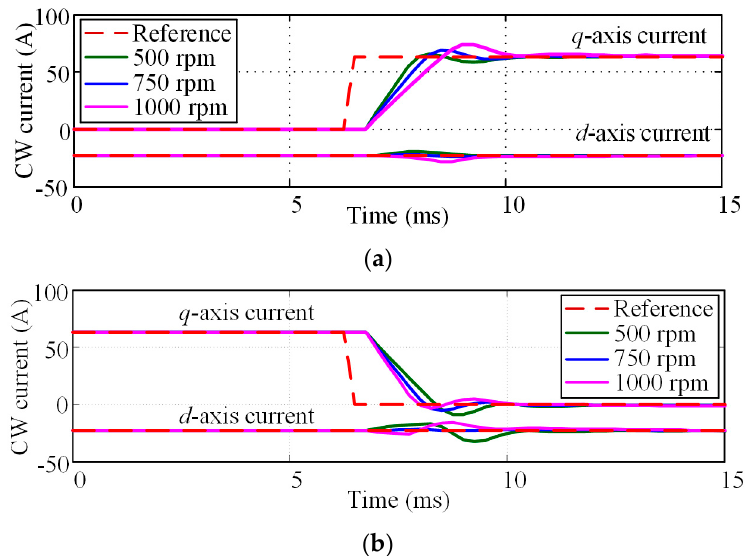
Figure 5. Dynamic responses of the CW current at different speeds (measure (solid); reference (dashed)). ( a ) i cq changes from 0 A to 63 A; ( b ) i cq decrease from 63 A to 0 A. ( a ) i cq changes from 0 A to 63 A; ( b ) i cq decrease from 63 A to 0